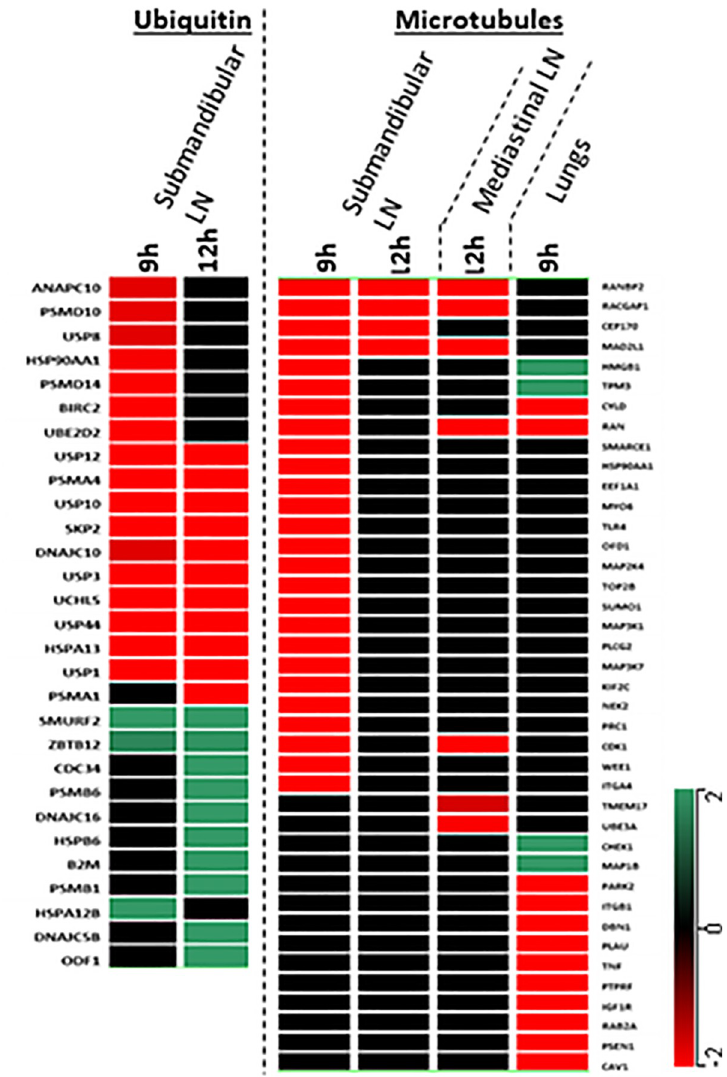
Fig 2. Hierarchical clustering of the genes linked to ubiquitin and microtubules networks. Genes clustered here showed alteration in at least one of the two early time points, 9 h and 12 h p.i. Ubiquitin-associated genes located in submandibular LN are shown in the left hierarchical tree. These genes linked to ubiquitination weren’t expressed in the lungs or mediastinal LN. All of these genes are listed in Table 3, which is in the same order as that in the figure. From the pool of genes linked to microtubule network, only those were mined that ranked in the primary and secondary tiers computed by GIH algorithm. Genes showing early (9 h or 12 h p.i.) alteration in expression are clustered in the right column. All of these genes are listed in Table 4 is in the same order as that in the figure. A scale depicting the range of color corresponding to the gene expression levels is shown at right.